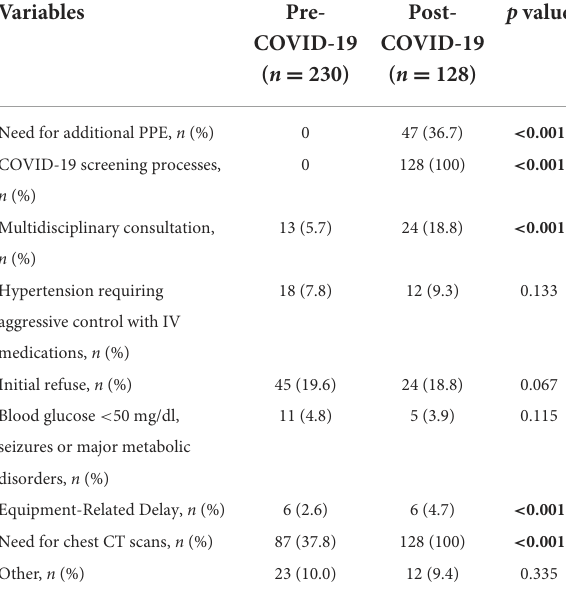
TABLE 4 Influencing factors for delayed mechanical thrombectomy treatment.